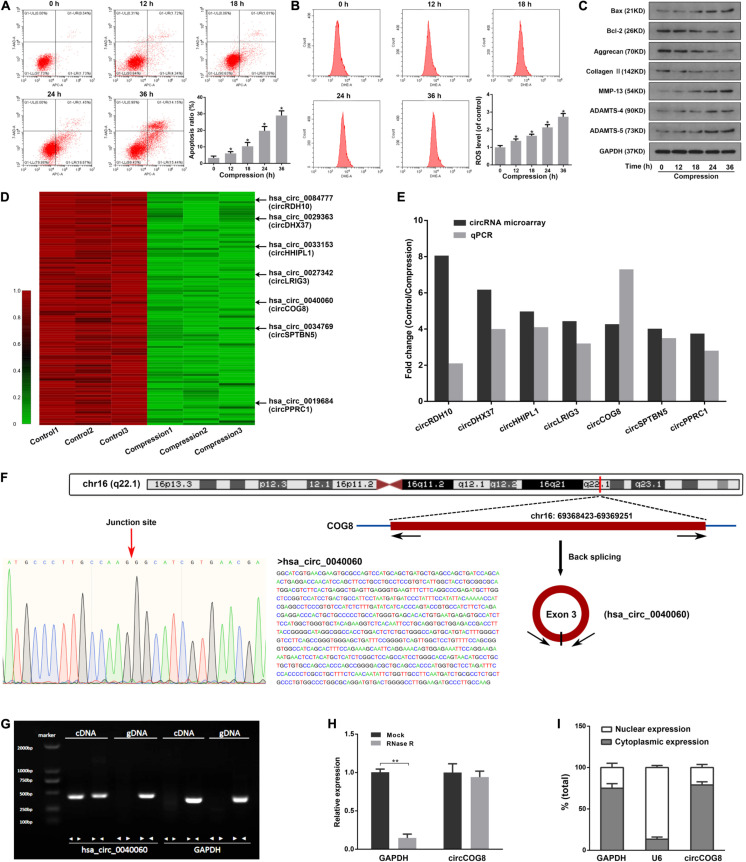
CircCOG8 was significantly down-regulated in the compression-treated human NP cells. (A) The human NP cells were treated with 1 MPa compression for the indicated time points (0, 12, 18, 24, and 36 h), and the cell apoptosis was determined by the Annexin V-APC and 7-AAD double-staining with subsequent flow cytometry analysis. Data were represented as mean ± SD. 0 h group served as a control, *p < 0.05 versus control, n = 3 (ANOVA with Tukey’s post-test). (B) The intracellular ROS production of the NP cells with compression for indicated time points were examined by the ROS-specific fluorescent probe DHE and measured by the flow cytometry analysis. Data were represented as mean ± SD. 0 h group served as a control, *p < 0.05 versus control, n = 3 (ANOVA with Tukey’s post-test). (C) Western blot analysis was used to detect the protein expression level of ECM anabolism markers (Aggrecan, Type II collagen), ECM catabolism enzymes (MMP-13, ADAMTS-4, ADAMTS-5), and apoptosis-associated markers (Bax, Bcl-2). Data were normalized to the GAPDH control. The GAPDH band served as a common internal loading control for Bax, Bcl-2, Aggrecan, Type II collagen, MMP-13, ADAMTS-4, and ADAMTS-5. (D) Clustered heat map showed the top 100 significantly down-regulated circRNAs in three samples of the compression treated human NP cells and three control samples. The arrows indicated the seven candidate circRNAs which were further validated using a real-time qPCR analysis. (E) Comparison of the fold changes for the seven candidate circRNAs from the circRNA array and real-time qPCR validation. (F) The genomic loci of the COG8 gene and circCOG8. The expression of circCOG8 was validated by the Sanger sequencing. (G) The products amplified using the divergent or convergent primers were verified by agarose gel electrophoresis. Divergent primers were used to amplify circCOG8 in cDNA but not in genomic DNA (gDNA). Convergent primers could amplify both the circCOG8 and linear RNA GAPDH. (H) The RT-qPCR analysis of circCOG8 and linear control GAPDH mRNA after treatment with RNase R in the disk NP cells. **p < 0.05, n = 3. (I) RT-qPCR assay in nuclear and cytoplasmic fractions showed the levels of nuclear control transcript (U6), cytoplasmic control transcript (GAPDH), and circCOG8.